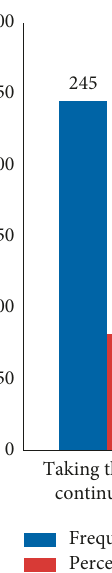
Figure 1: Contribution of the community towards the success of CDT with Ivermectin from Gesha town, Ethiopia.